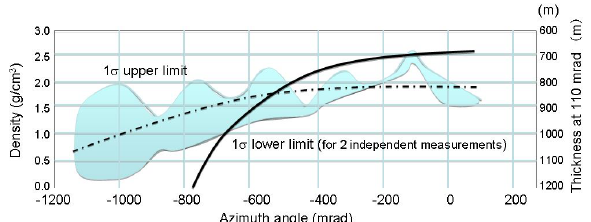
Fig. 6. Density distribution of 1910 MS mound as a function of azimuth angle. The 1 σ upper and lower limits for the measurement is shown in the blue region. The broken line shows the result of taking moving average of the density distribution. The solid line indicates the thickness of the target at an elevation of